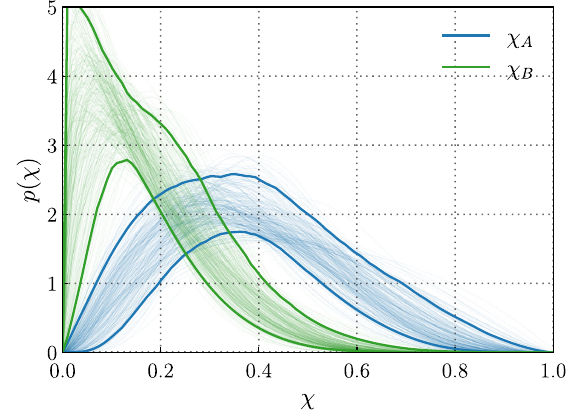
FIG. 17. Distribution of magnitudes of the most ( χ ) and least A ( χ ) rapid component spin among BBHs in GWTC-3. Traces B show individual draws from our posterior on the spin population under the D EFAULT model, while dark curves indicate 90% credible bounds on p ð χ and p ð χ . A Þ B Þ